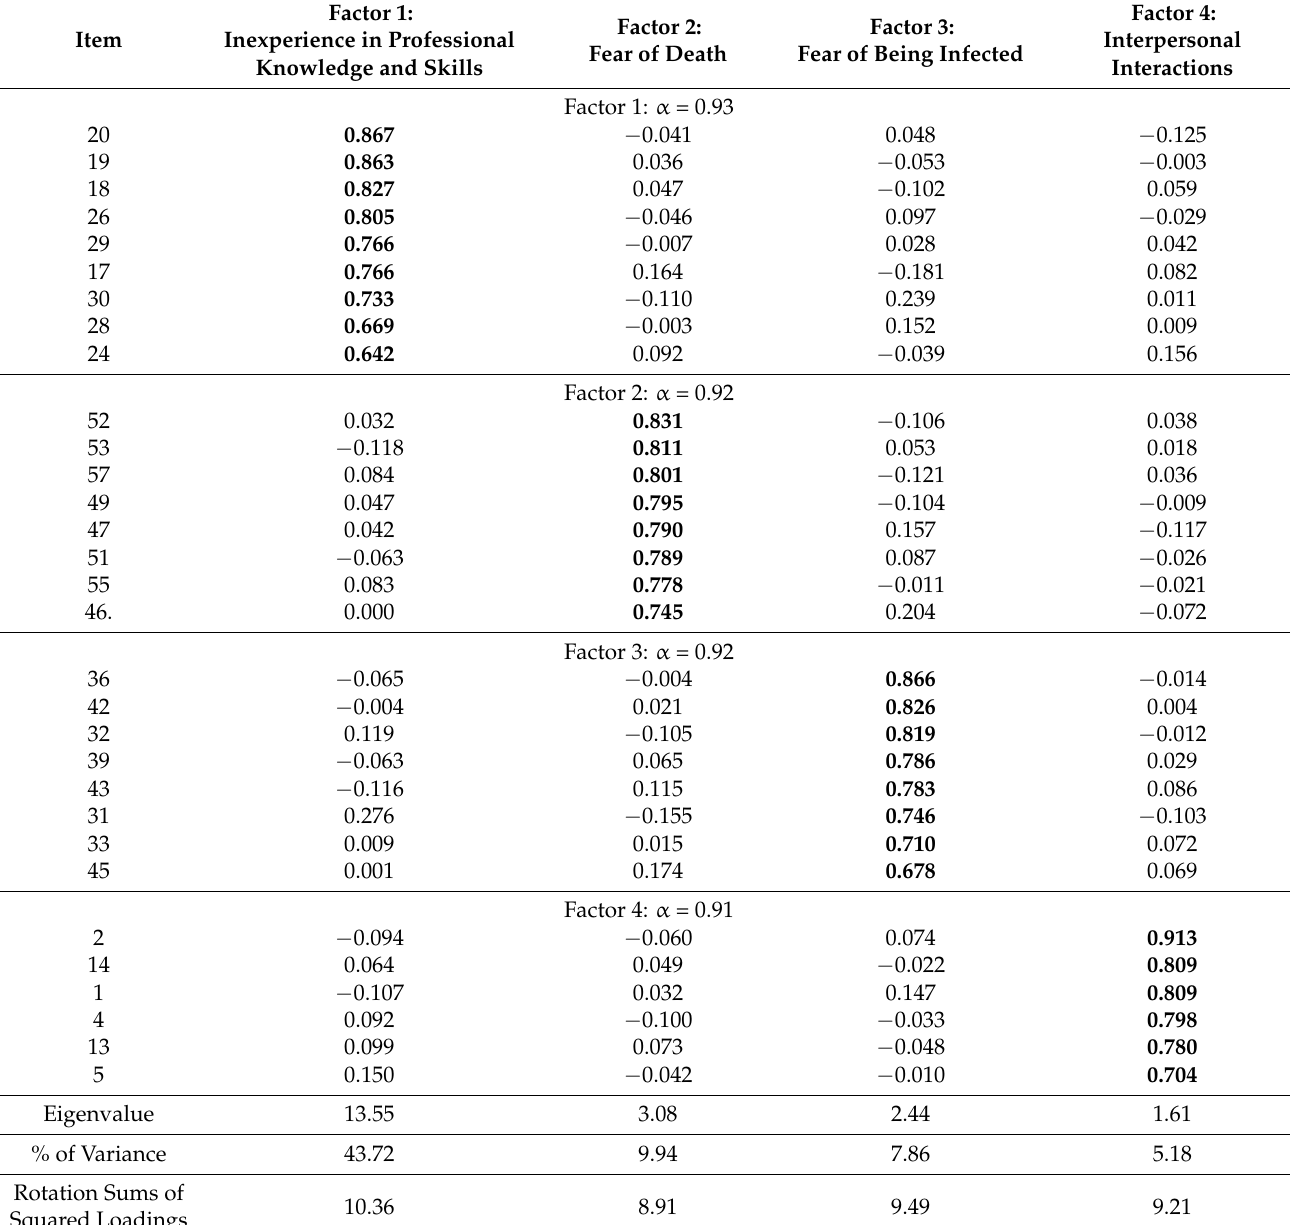
Table 1. Rotated factor loading after the promax rotation for the